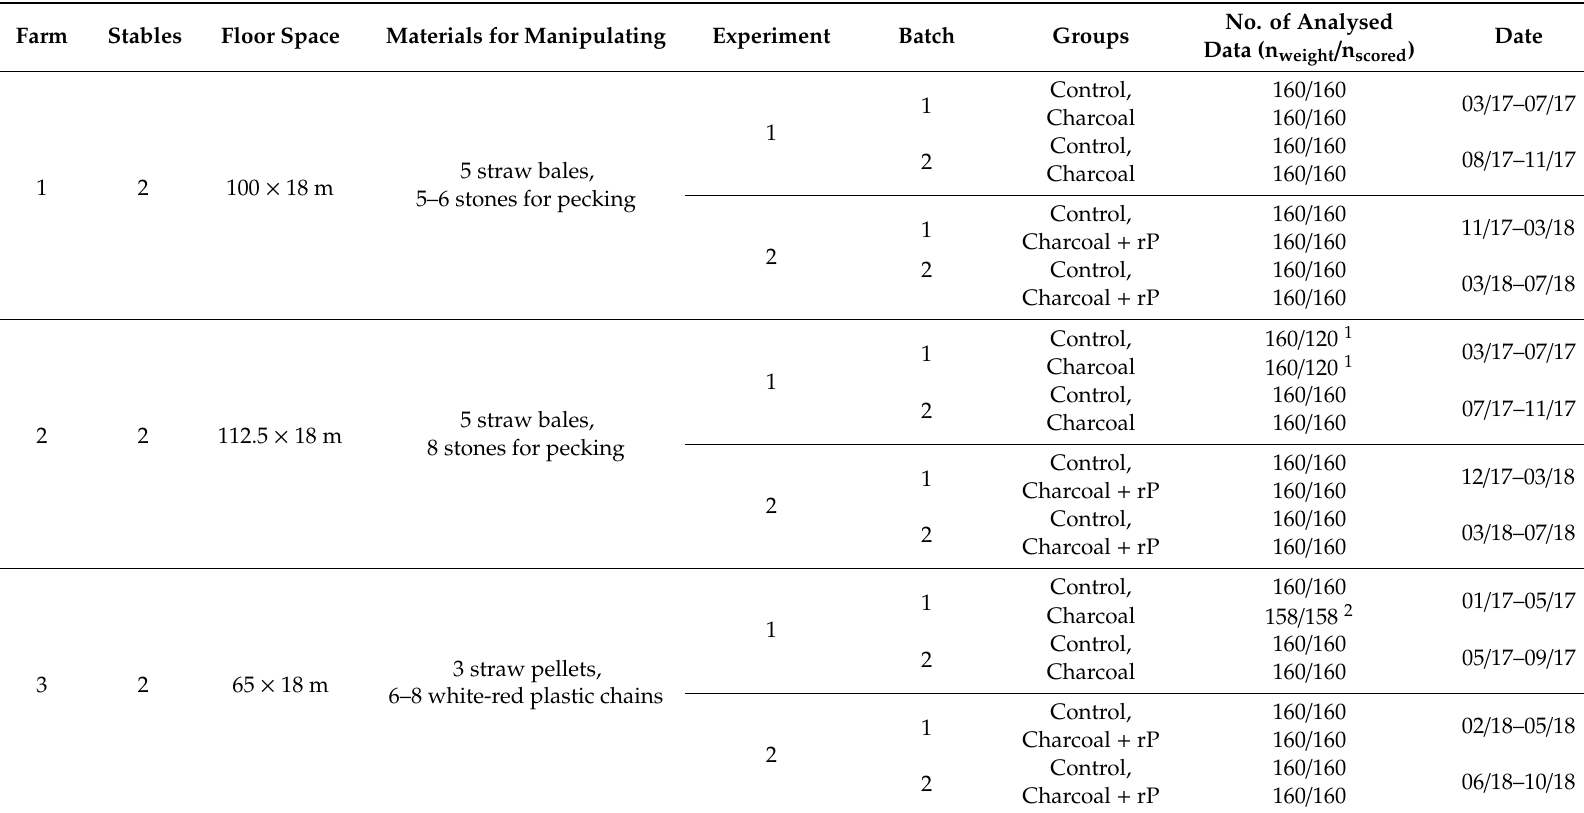
Table A1. Details about the periods of the batches, about the groups and the number of analysed data and about the stables and materials for manipulating in the di ff erent farms during the Experiments 1 and 2 (reduced Protein =